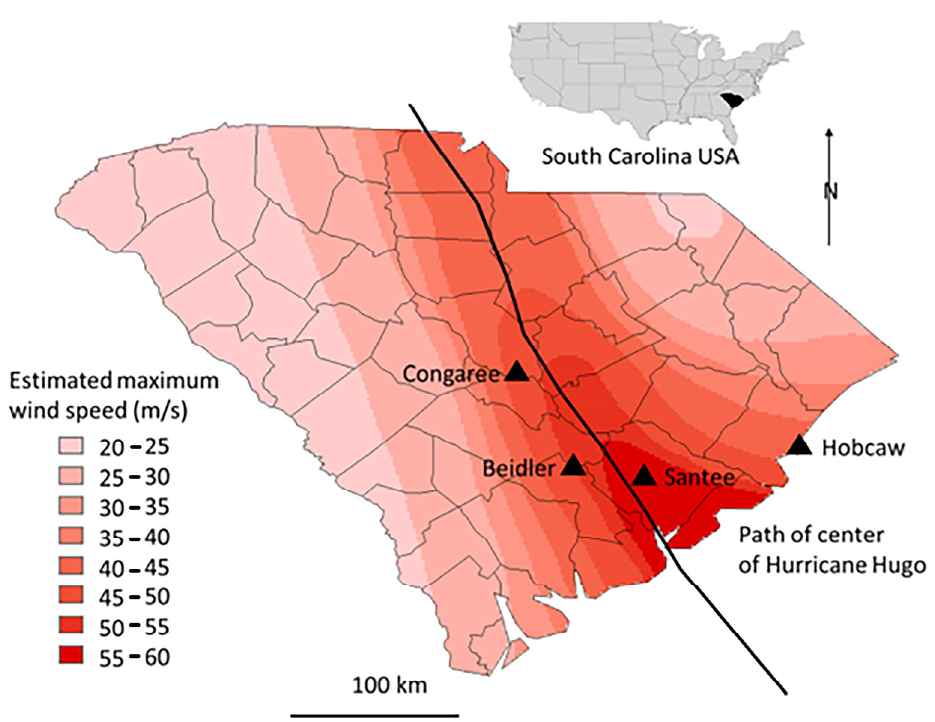
Figure 2. Illustration of the location of the four research sites in relation to: the coast of South Carolina, USA, the path of the eye of Hurricane Hugo [21], and the estimated maximum wind speeds based on damage evaluated on the Fugita scale [24].